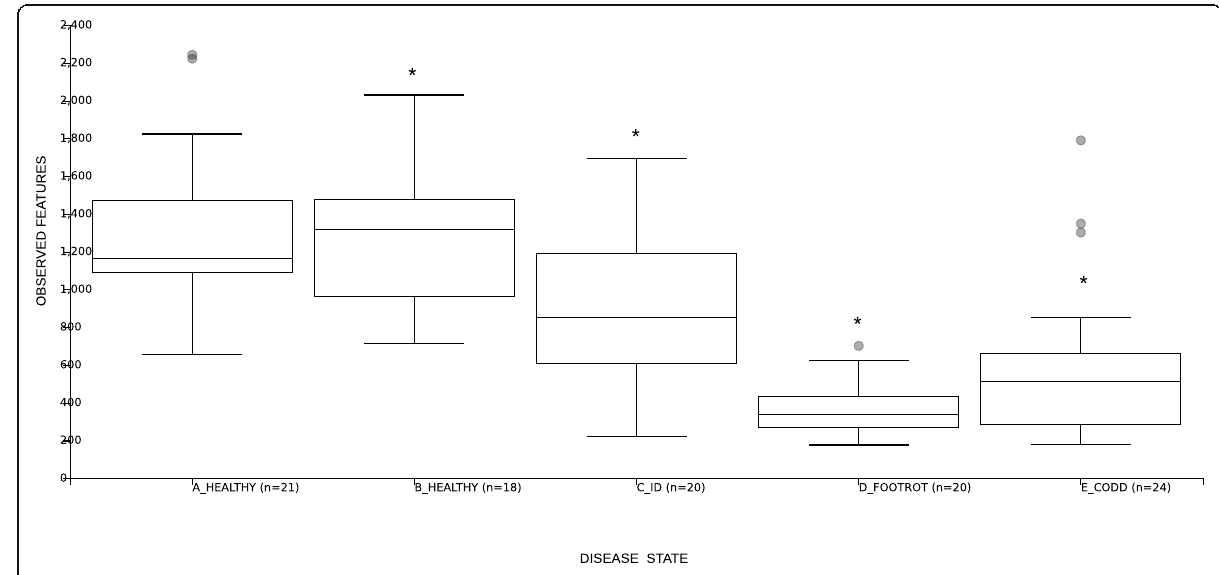
Fig. 2 Box and whisker plots of alpha diversity as measured by observed ASVs for the different stages of CODD lesion development. * represents p < 0.05